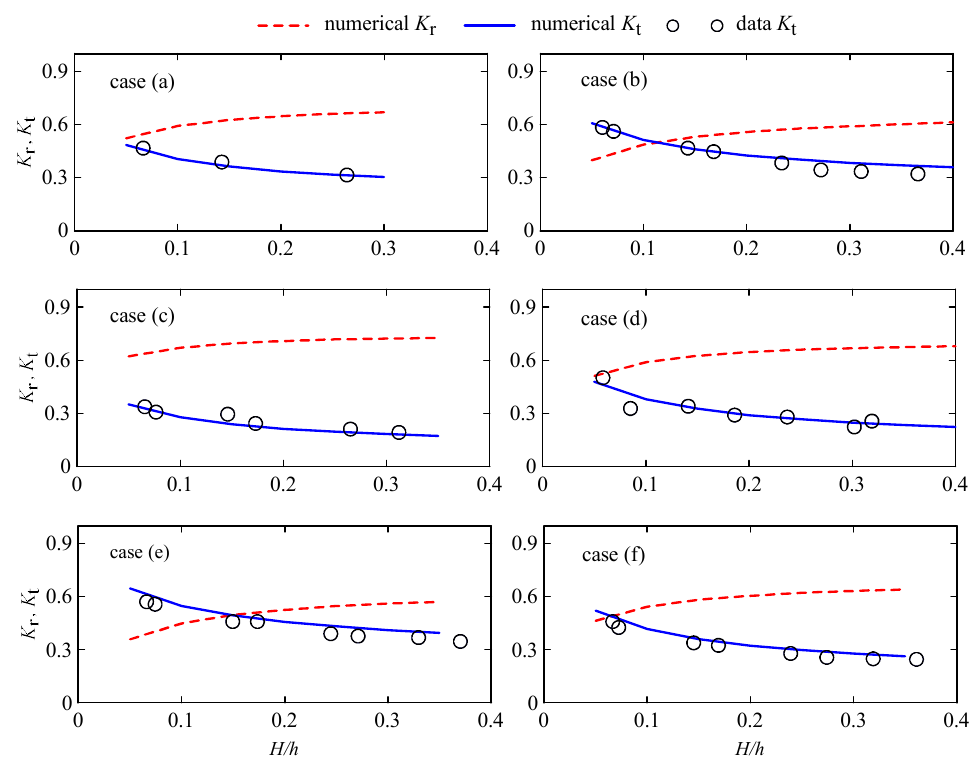
Figure 6. Reflection and transmission coefficients versus wave nonlinearity for solitary waves passing through porous breakwater of Vidal et al.’s experiments [36].